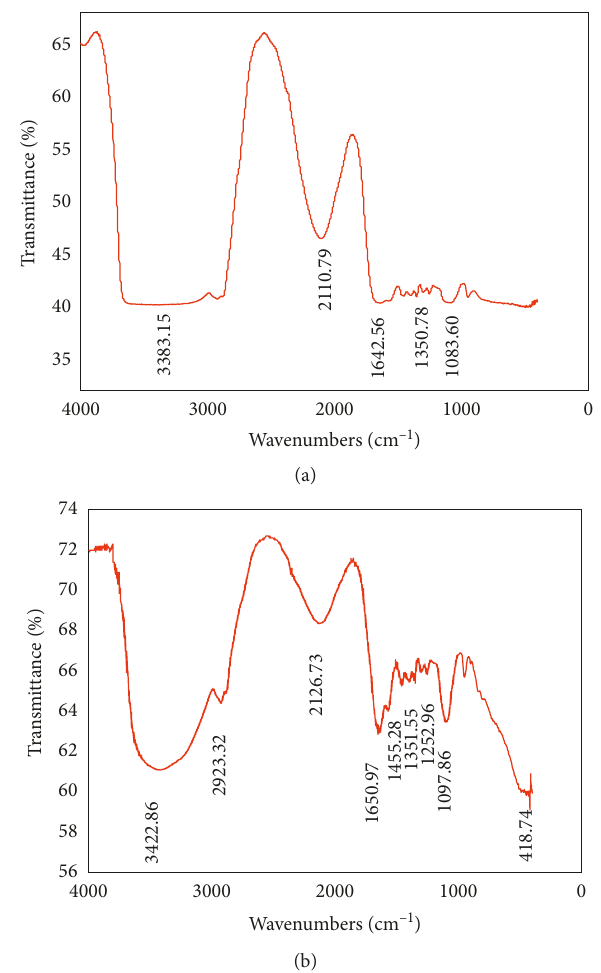
Figure 5: Infrared spectrograms of PCS produced (a) with wheat straw and (b) without wheat